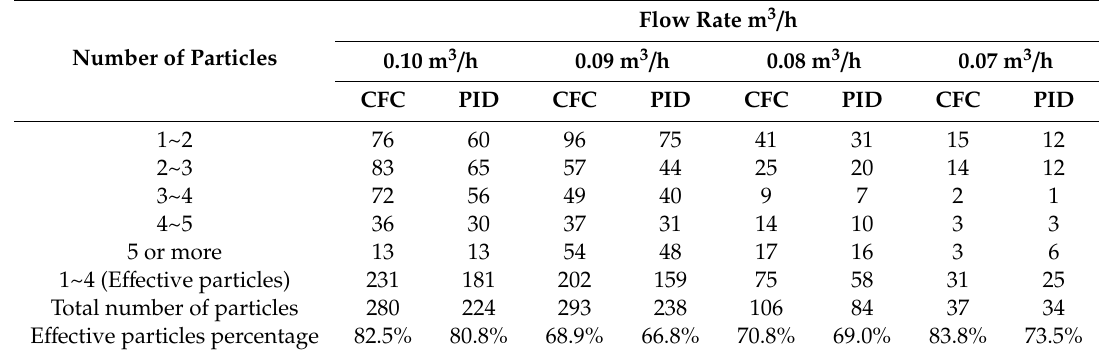
Table 5. Spray conditions at various flow rates at the pressure of app. 0.4 MPa.